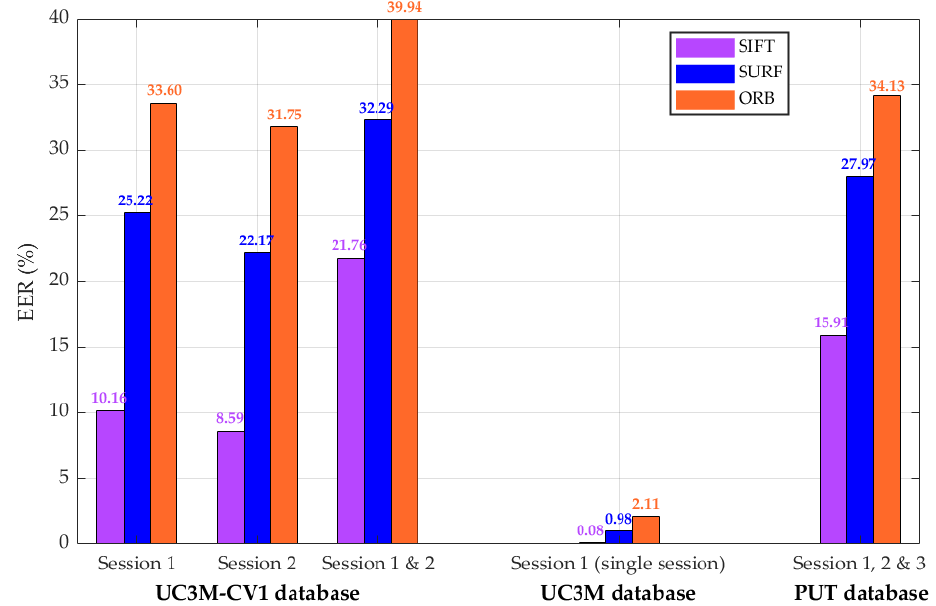
Figure 14. Results: Biometric system performance. Equal Error Rate (EER) obtained for each database using TGS-CVBR ® and PIS-CVBR ® with SIFT ® , SURF ® , and ORB algorithms.